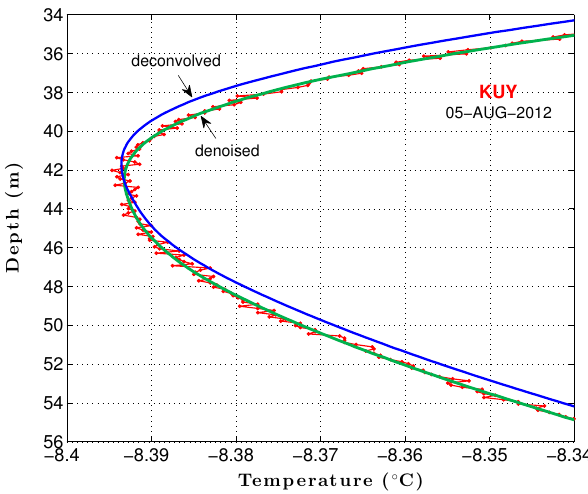
Figure 7. Portion of a sample DOI/GTN-P temperature log (Kuyanak Test Well #1, 5 August 2012). The temperature measurements T are shown in red while the denoised signal is given by the green line. Blue line shows the deconvolved signal, which represents the actual temperatures T in the borehole taking into account the response time of the moving probe. Figure 9. Temperature profiles in the Awuna Test Well No. 1, color-coded by acquisition date (left). Temperature gradients calculated from the 1989, 2002, and 2012 logs are shown in the right panel.